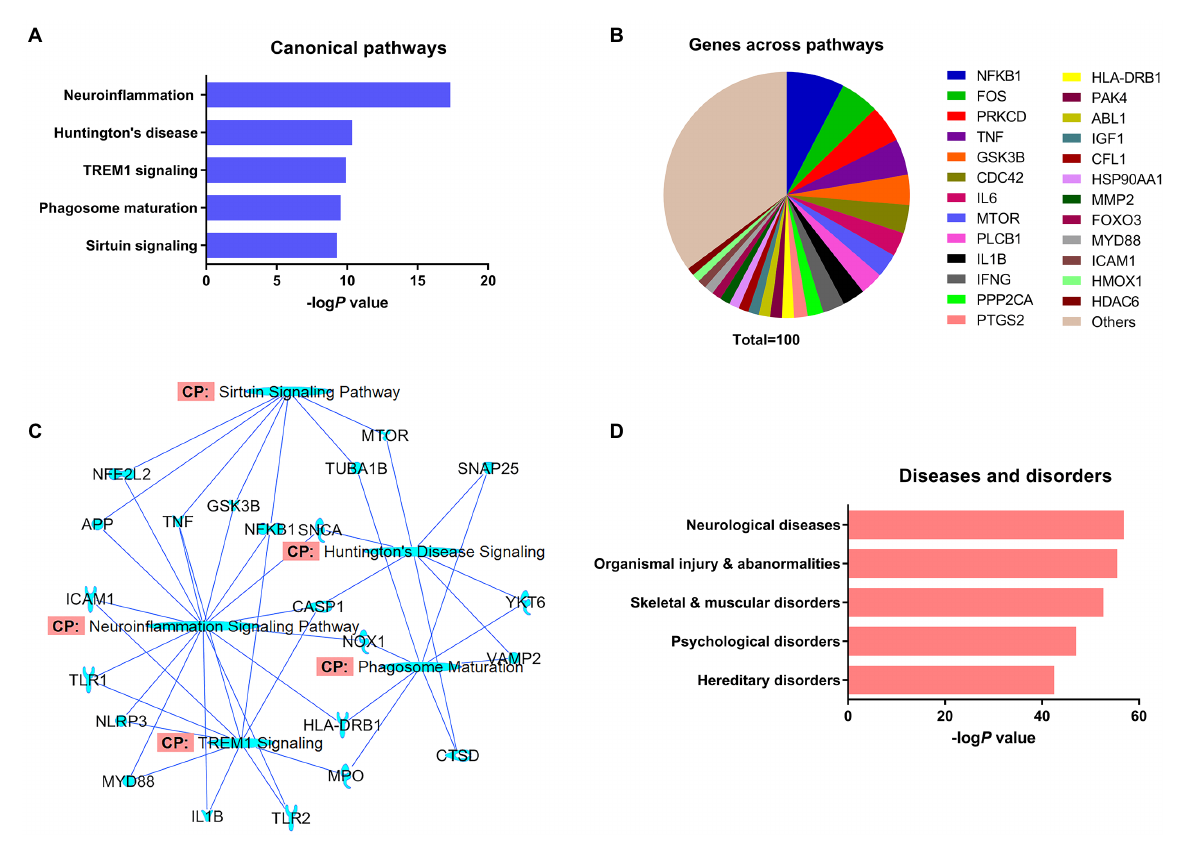
FIGURE 2 The expression analysis of differentially regulated α -synuclein and associated genes from the NCBI dataset by IPA. (A) Top-ranked canonical pathways of α -synuclein. (B) Significantly populated α -synuclein-associated genes from the NCBI dataset that appeared in the predicted canonical pathways. (C) Overlapping of the top-ranked canonical pathways of α -synuclein and α -synuclein-associated genes from the dataset. (D) Top- ranked diseases and disorders of α